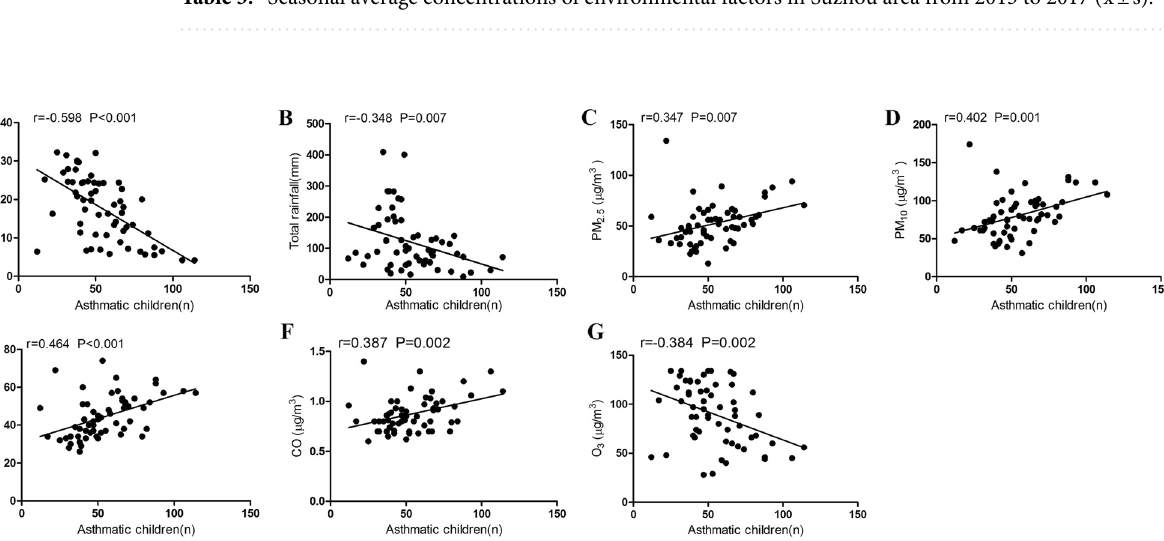
Table 3. Seasonal average concentrations of environmental factors in Suzhou area from 2013 to 2017 ( x ± s).